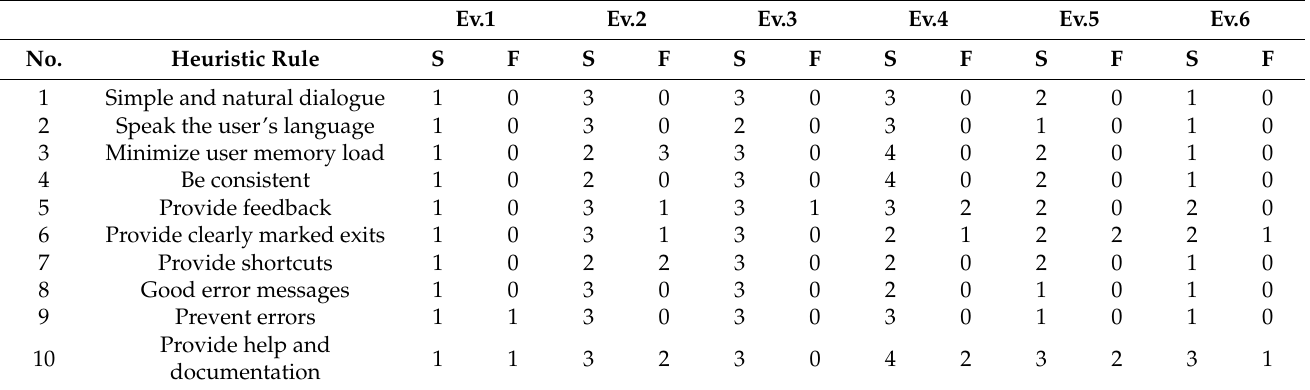
Table 4. Heuristic evaluation